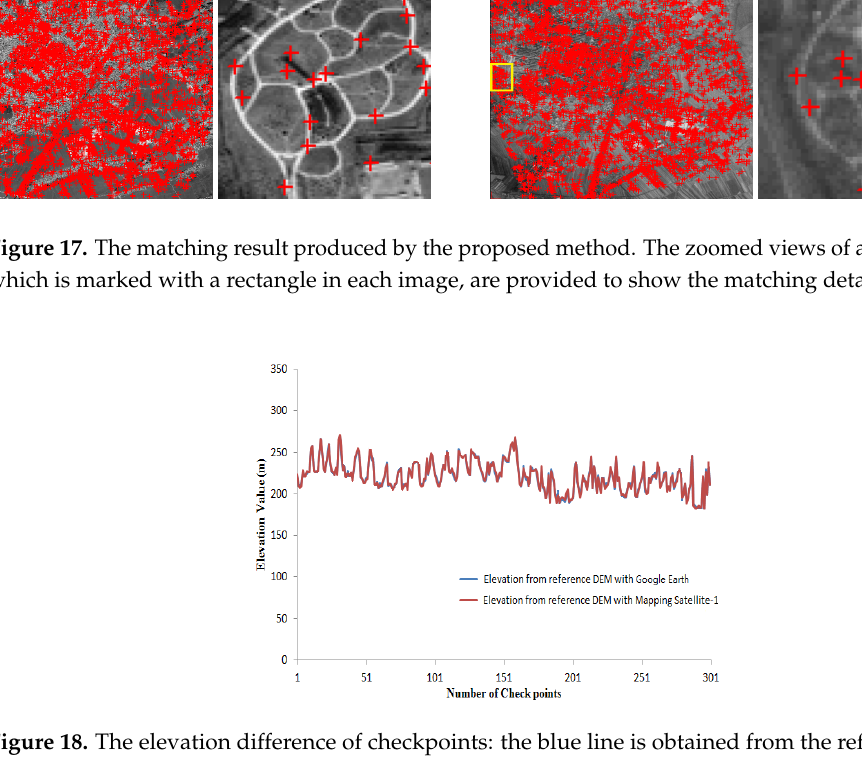
Figure 18. The elevation difference of checkpoints: the blue line is obtained from the reference DEM with their geographic coordinates from Google Earth, and the red one is from the reference DEM by the iterative approach mentioned in Section 2.2 with their image coordinates in the Mapping Satellite-1